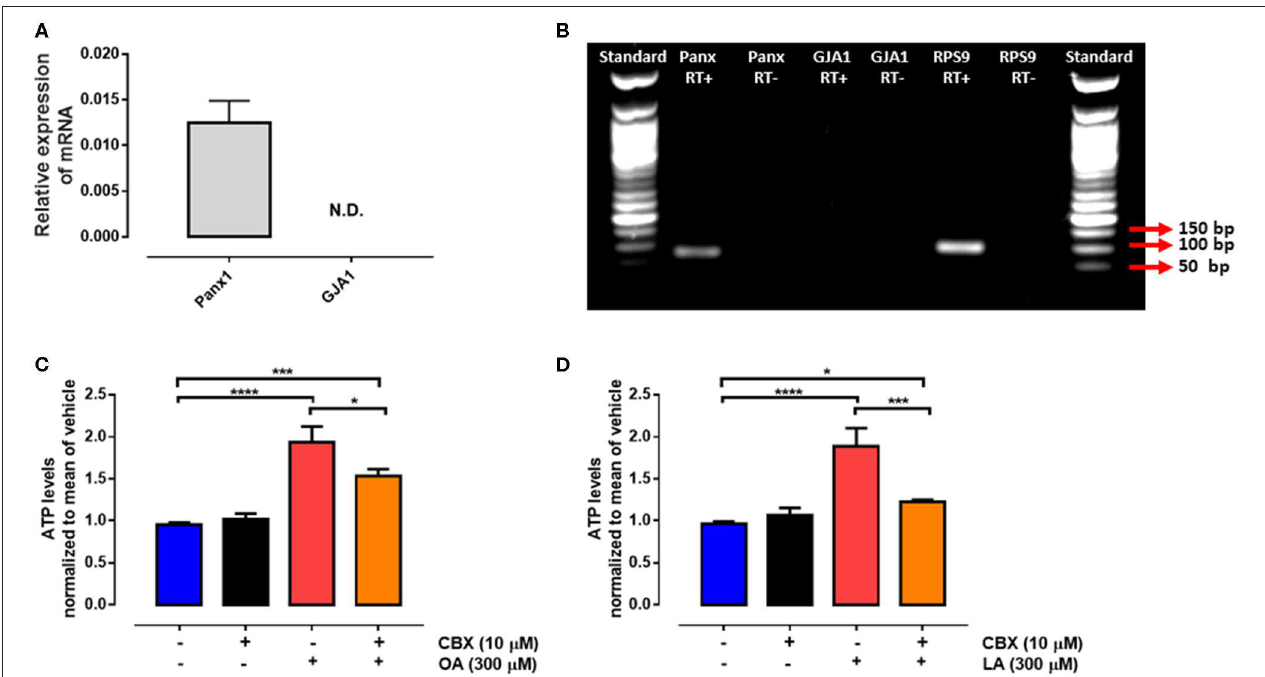
FIGURE 3 | Non-esterified fatty acid (NEFA)-induced ATP release is mediated via PANX1. Relative expression of PANX1 to RPS9 (housekeeping) in bovine PMN assessed by RT-qPCR (A) , n = 4. Gel of mRNA amplicons of PANX1 , GJA1 , and RPS9 (B) . N.D.: not detected. bp: base pair. RT + , RT–: reverse transcriptase + , reverse transcriptase -. Bar graph showing ATP release from PMN treated with 10 µ M carbenoxolone (CBX) for 15min and then stimulated with oleic acid (OA) (C) or linoleic acid (LA) (D) for 30min. n = 4; * p < 0.05, *** p < 0.001, **** p < 0.0001 compared with vehicle